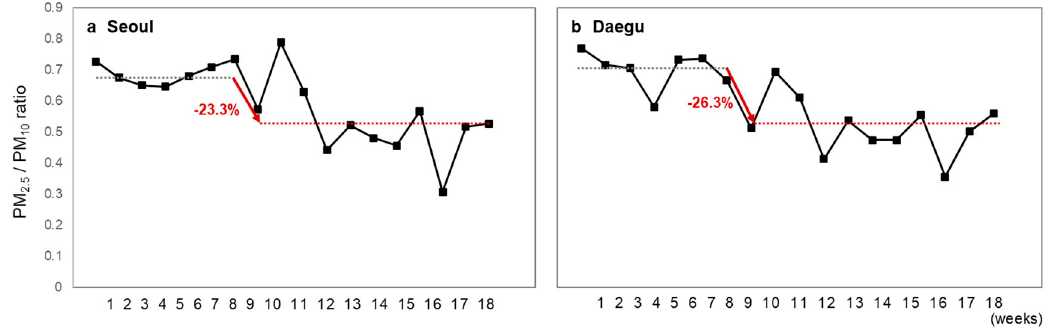
Figure 5. Changes in weekly PM 2.5 / PM 10 ratios in ( a ) Seoul and ( b ) Daegu. The black dotted line represents the average ratio before SD, and the red dotted line represents the average ratio after SD. The reduction in the PM 2.5 / PM 10 ratio is highlighted.